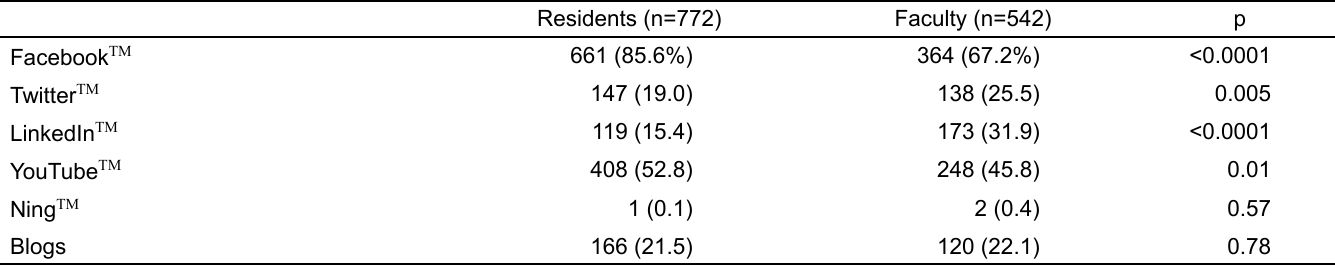
Table 4. Use of specific social media